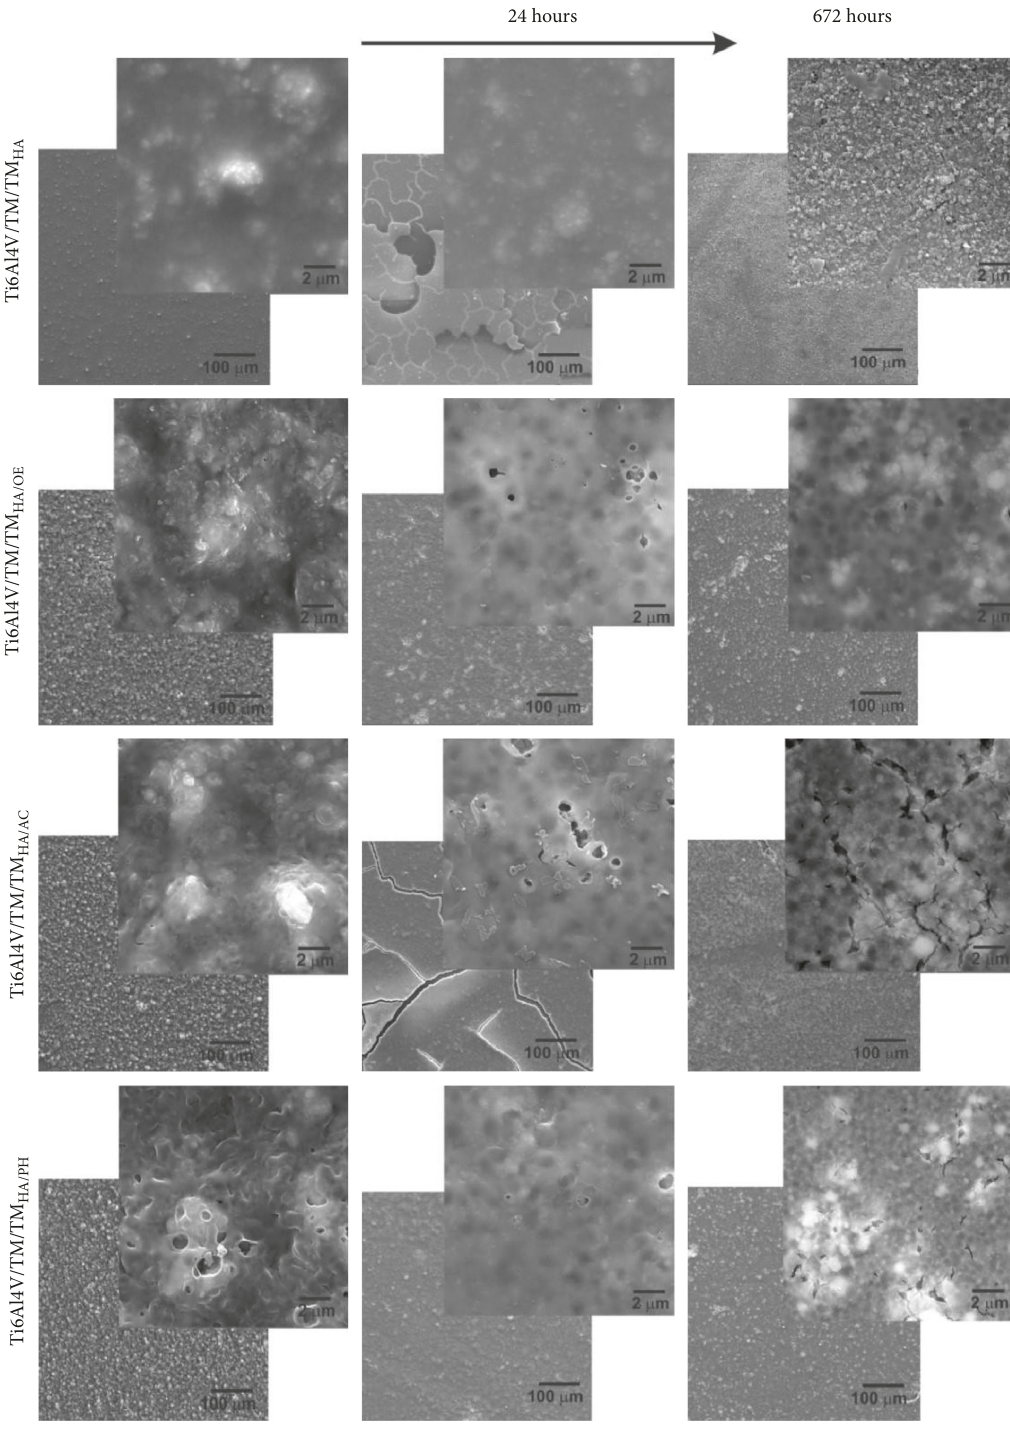
Figure 8: SEM/FEG micrographs of the nonsterilized and the sterilized (by three different processes) coatings immersed for 24 and 672hours in SBF at 37 ± 3 °